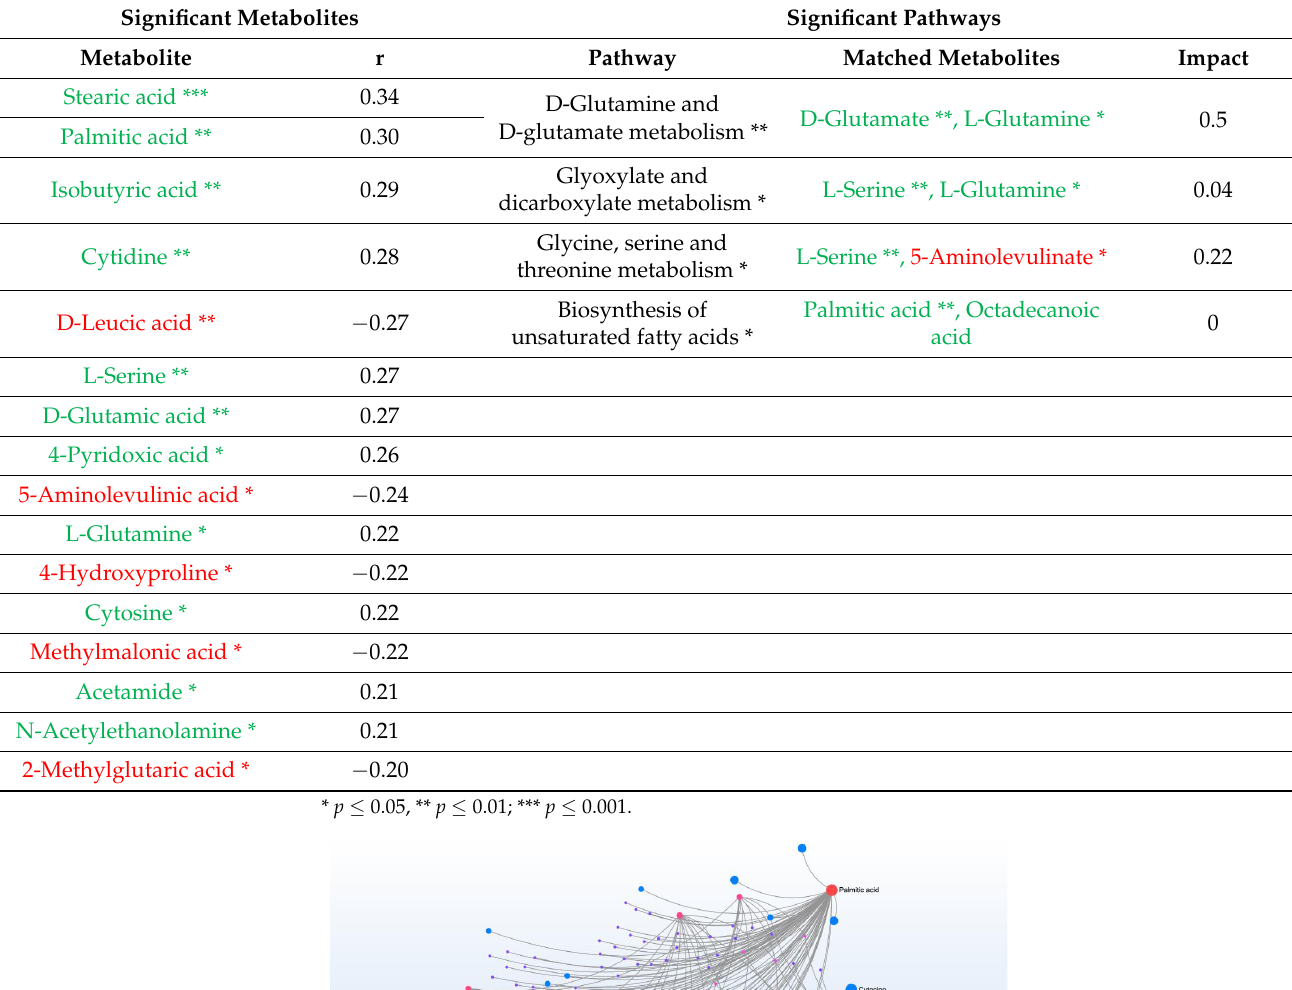
Table 14. Metabolites and their pathways which correlate with oxidative damage.